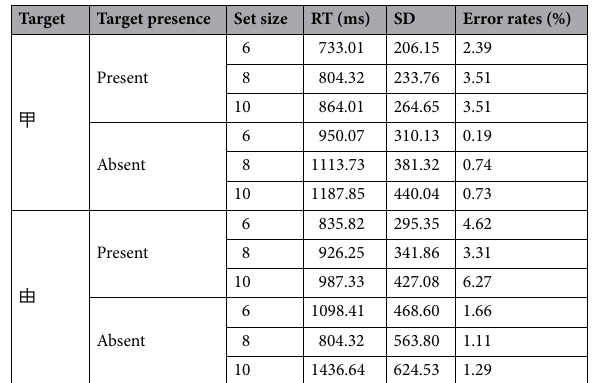
Table 1. RTs and error rates in Experiment 1.